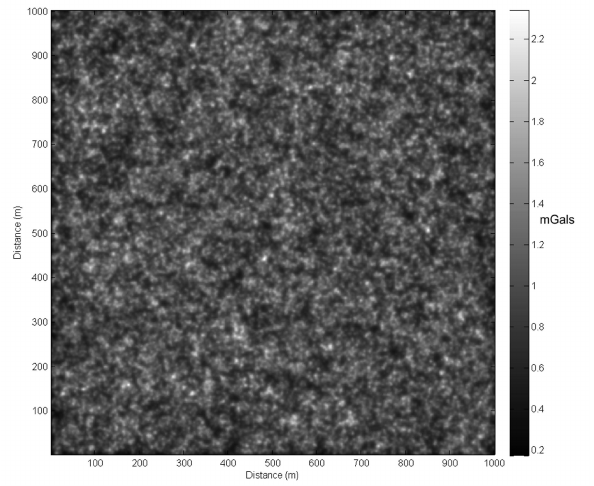
Fig. 1a. The gravity response from 100000point sources, each with a mass of 10 11 kg and a depth of 5m.